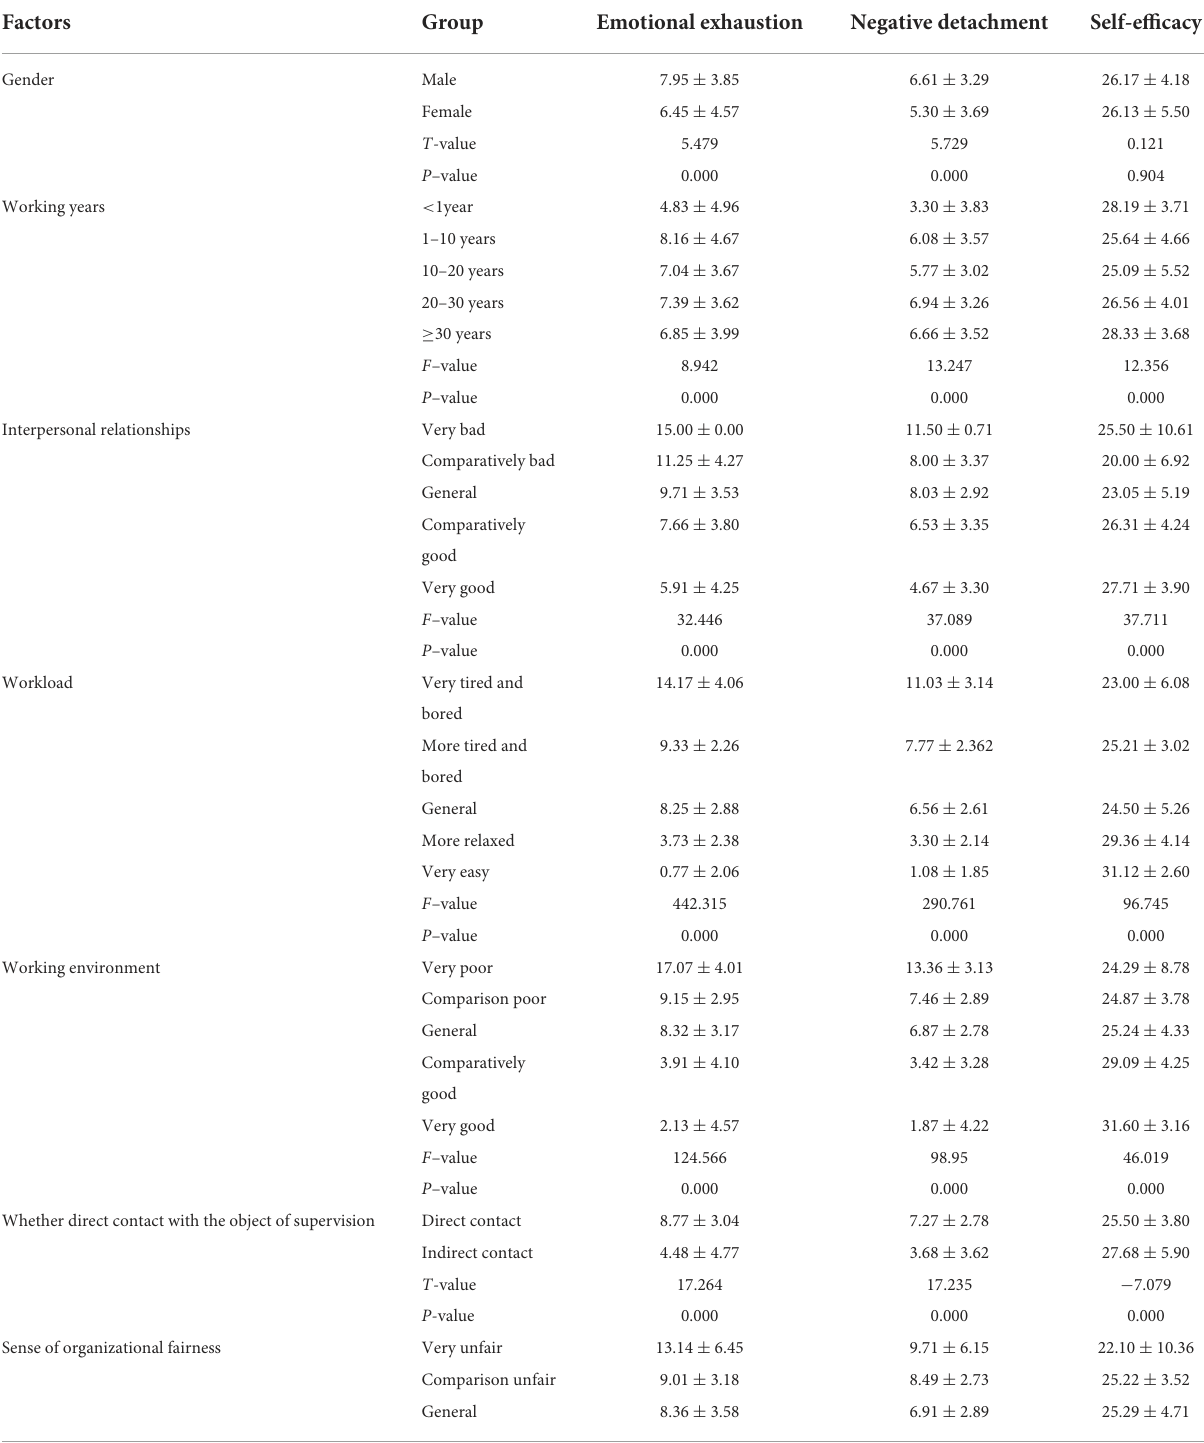
TABLE 5 Single-factor analysis of burnout among prison